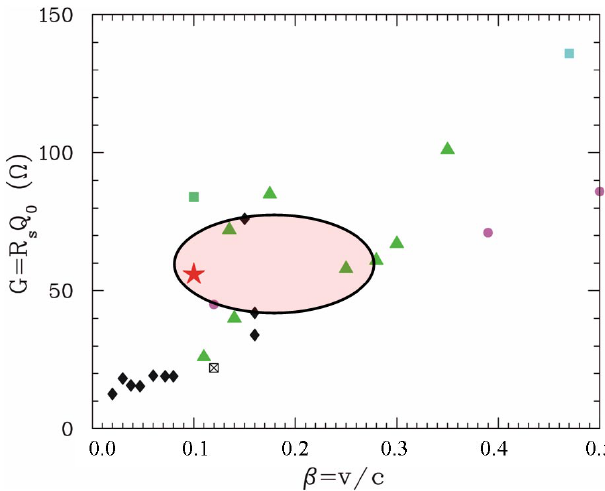
Q as a function of s 0